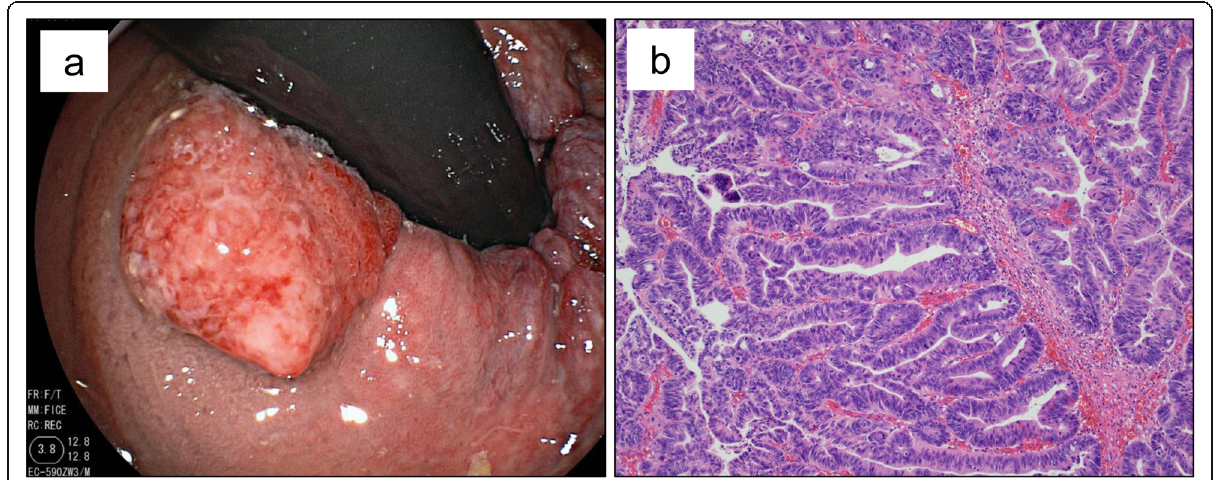
Fig. 1 Colonoscopy 5 years prior to presentation revealed a 13-mm semi-pedunculated polyp in the rectum. a Histologic findings showed well- differentiated adenocarcinoma in situ. b (×200)